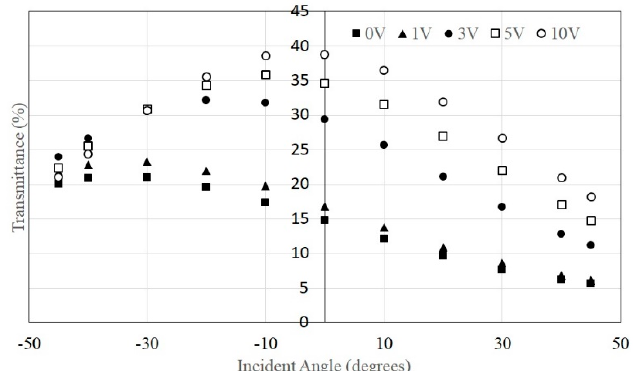
Figure 10. Incident angle dependencies of the transmittance for the two-layer HAN-LCDs using LC materials containing 3 wt.% of dichroic dye with applied voltages.